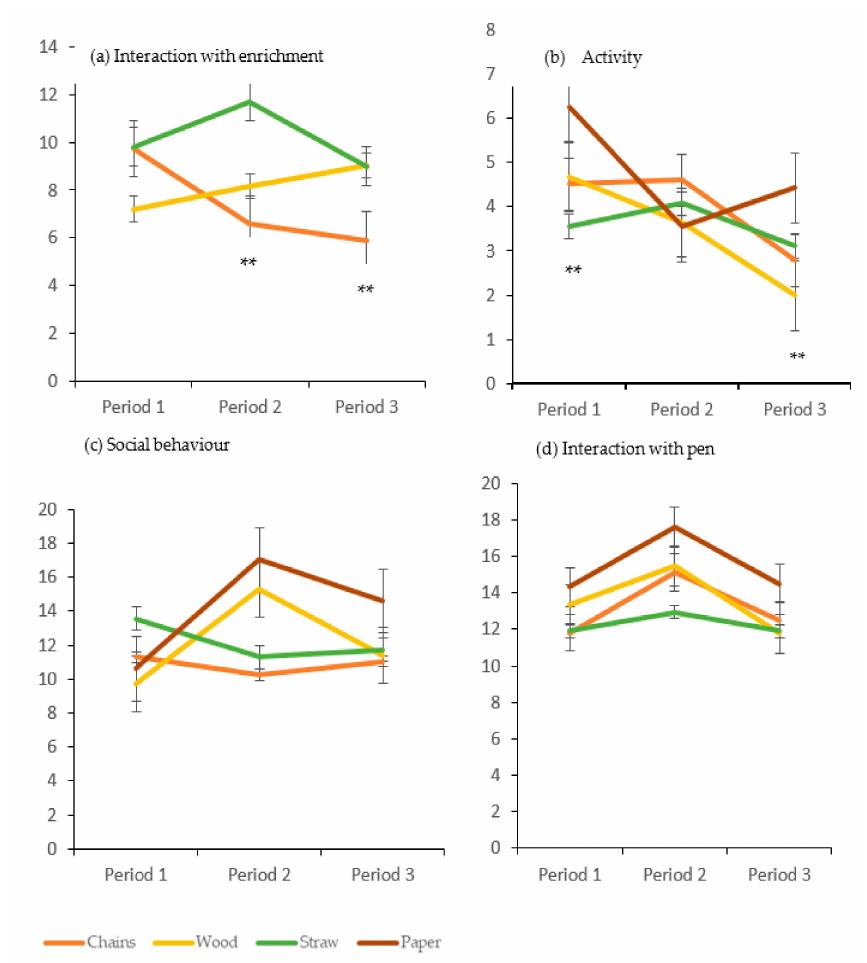
Figure 1. Behaviours observed by scan sampling (Mean percentage and SE) for the 4 types of enrichment materials. 1-3: averaged observations for first, second and third month of observations. ** P < 0.01 (see text for explanation of statistical di ff